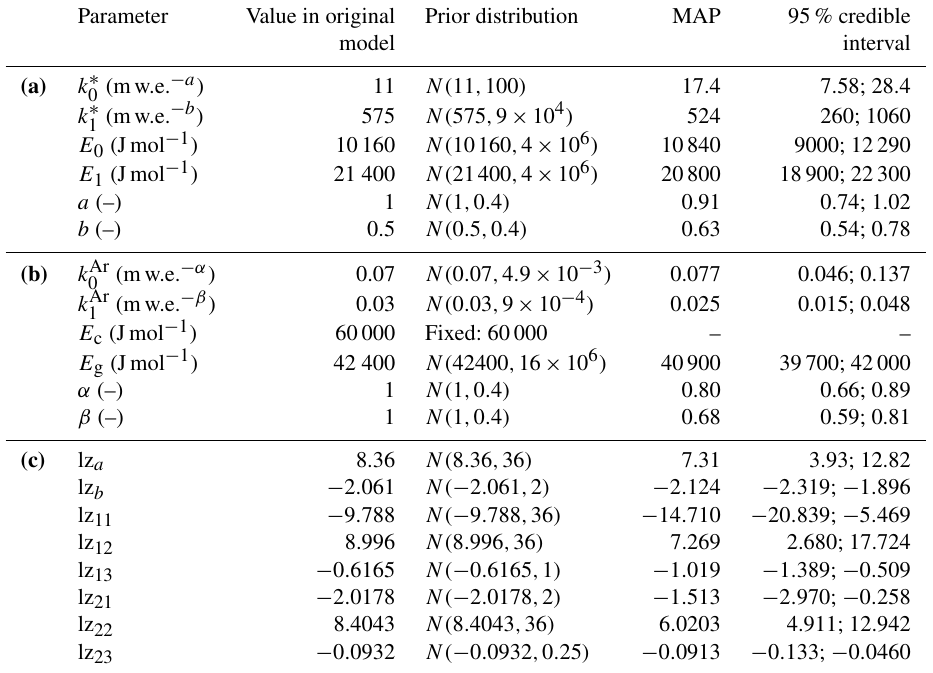
Table 1. Information for the free parameters of HL (a) , Ar (b) and LZ (c) . N(x,y) designates a normal distribution of mean x and variance y . The variances in the prior distributions are taken to generate weakly informative distributions. Some prior correlation is prescribed for the pairs ( k ∗ , E 0 ), ( k ∗ , E 1 ), ( k Ar , E g ), ( k Ar , E g ) and ( k Ar , k Ar ) (see Supplement). MAP estimates and credible intervals are results from the 0 1 0 1 0 1 calibration